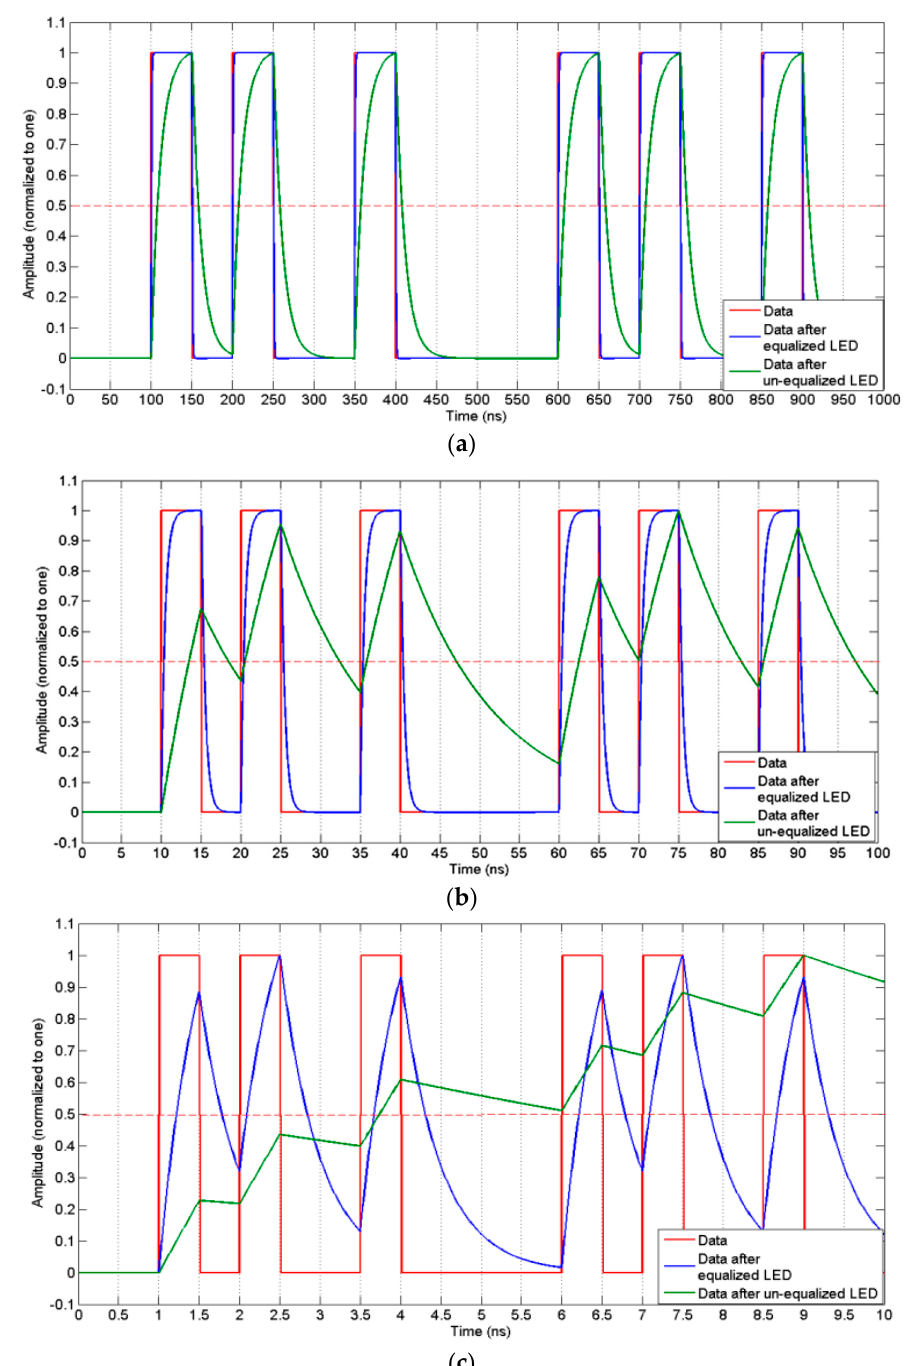
Figure 9. Data at rates of ( a ) 20 Mb/s, ( b ) 200 Mb/s, and ( c ) 2 Gb/s.